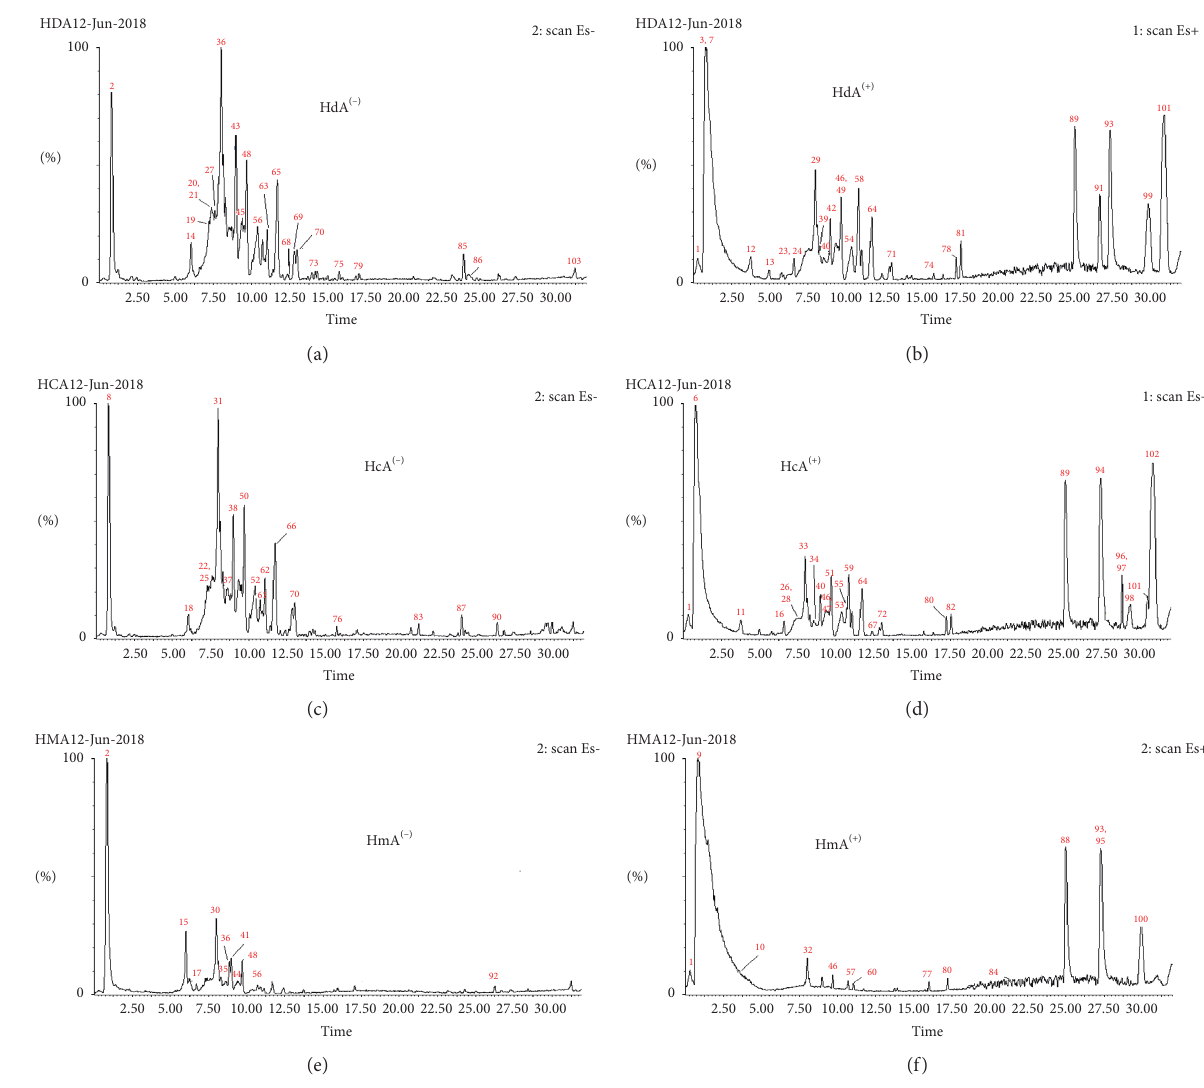
Figure 1: UPLS-ESI-MS chromatograms of aqueous extracts of aerial parts of H. deflersii (HdA), H. calyphyllus (HcA), and H. micranthus (HmA) in negative ( − ) and positive (+) ionization